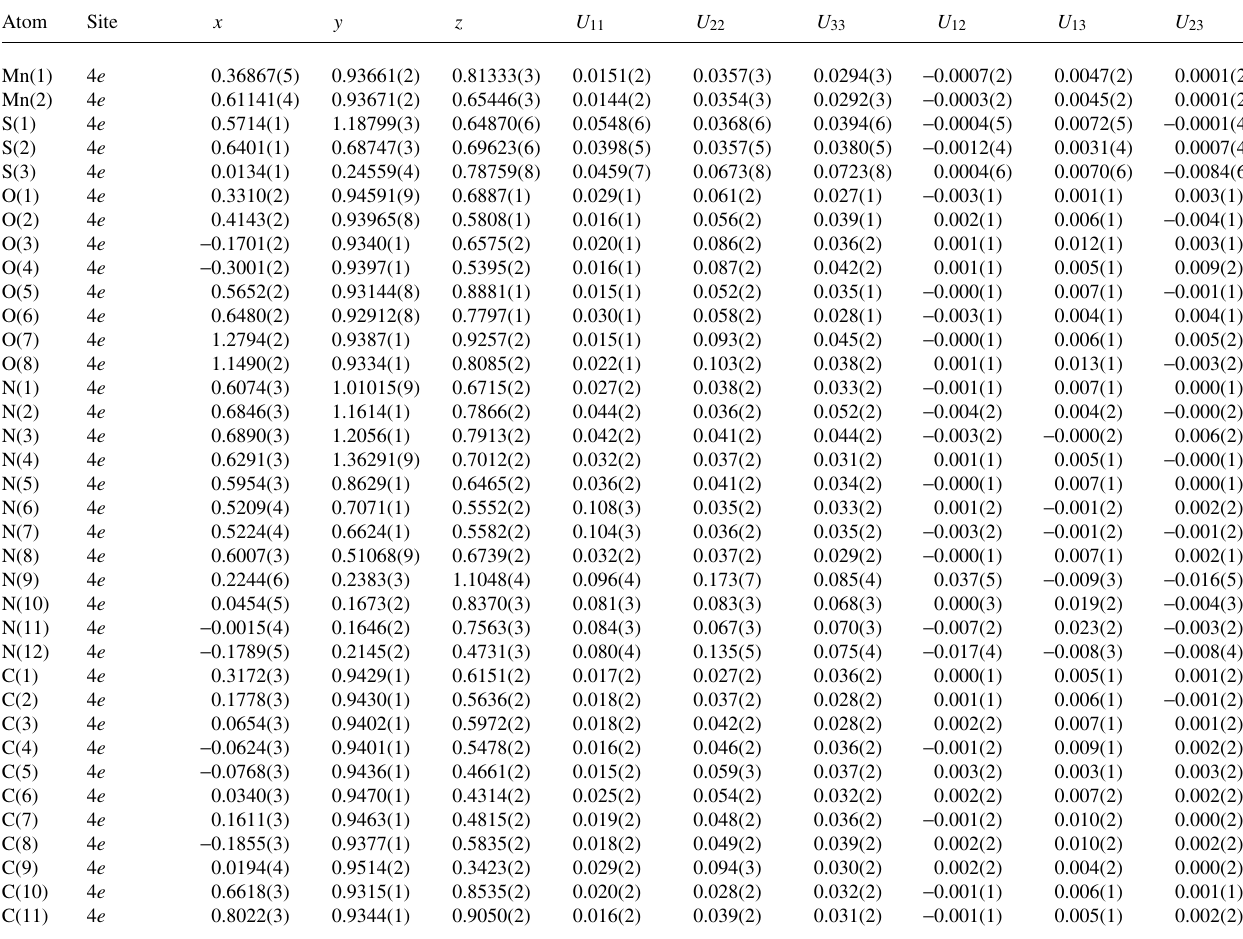
Table 3. Atomic coordinates and displacement parameters (in Å 2 ) .